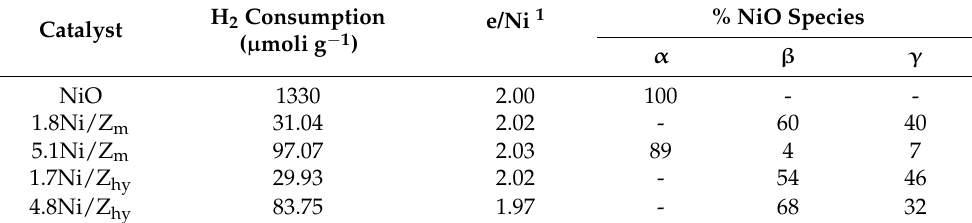
Table 3. H 2 -TPR results for NiO and Ni/ZrO 2 catalyst precursors.